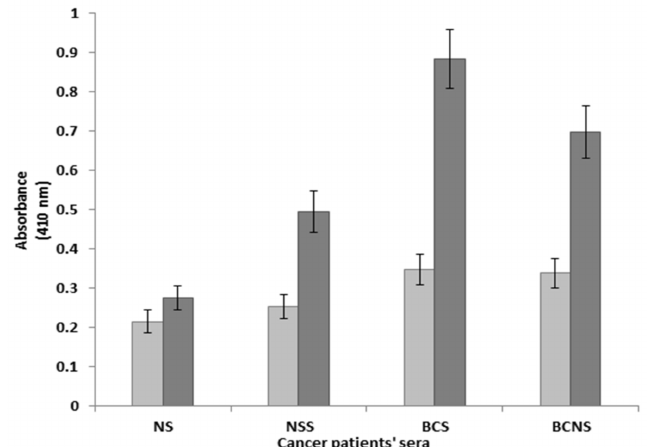
Figure 3. Direct binding ELISA of serum autoantibodies from bladder cancer patients of the smoker group (BCS) and the non-smoker group (BCNS) to native ( (cid:4) ) and N -OH-AABP-modified human DNA ( (cid:4) ). Normal human sera (NS) along with normal human smoker sera (NSS) served as a negative control. The histogram representing NS and NSS show mean absorbance values SD for binding of NS ( n = 20). The plate was coated with N -OH-AABP-modified human DNA (2.5 µ g/mL). The microtiter plates were coated with N -OH-AABP-modified human DNA (2.5 g/mL). The increase in autoantibodies in BCS and BCNS as compared to the NS and NSS is statistically highly significant. Both are statistically significant to the extent of more than